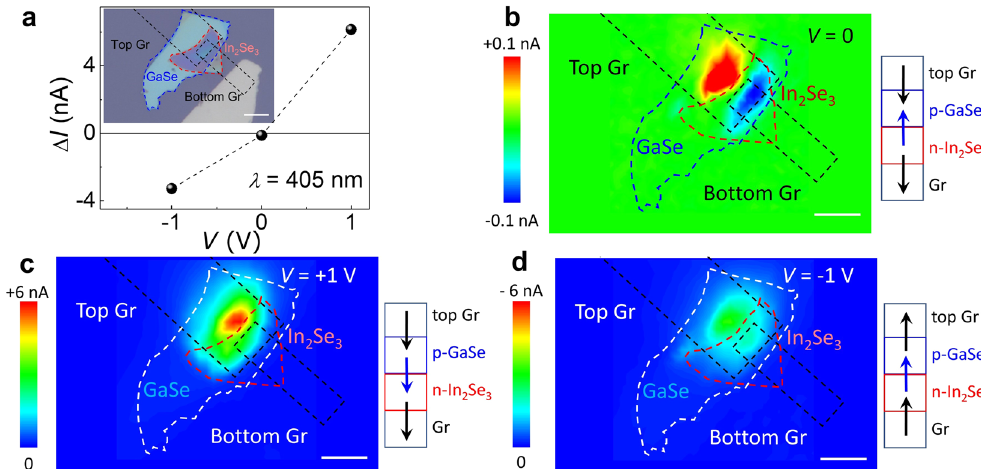
Fig. 5 Schottky contacts in graphene-contacted p -GaSe/ n -In 2 Se 3 heterojunctions. a Room temperature ( T = 300 K) photocurrent ( Δ I ) versus V under a focused laser beam ( λ = 405 nm and P = 5 μ W) for a junction (thickness of In 2 Se 3 /GaSe ~60/40 nm). The data correspond to the largest value of Δ I at each V . Inset: optical image of the device. Scale bar: 10 μ m. b – d Room temperature ( T = 300 K) photocurrent ( Δ I ) maps at b V = 0, c + 1 V and d − 1 V. The laser beam ( λ = 405 nm and P = 5 μ W) has a spot size of about 1 μ m. Scale bar: 10 μ m. The right insets in b – d illustrate the direction of the current across the three interfaces of the heterostructure.